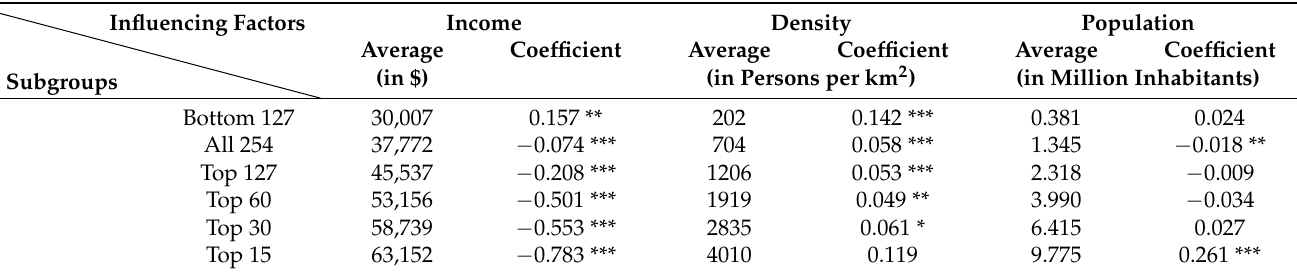
Table 9. Summary table of income, density, and population coefficients (2001–2013).